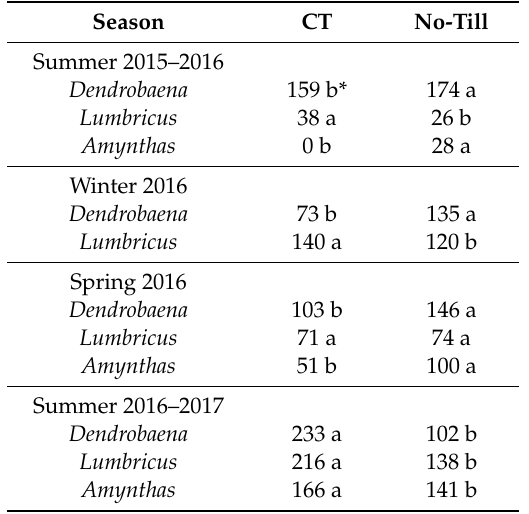
Table 4. Tillage e ff ects on earthworm genus composition (counts m − 2 ) during summer 2015–2016, winter 2016, spring 2016, and summer 2016–2017 seasons at the UFH research